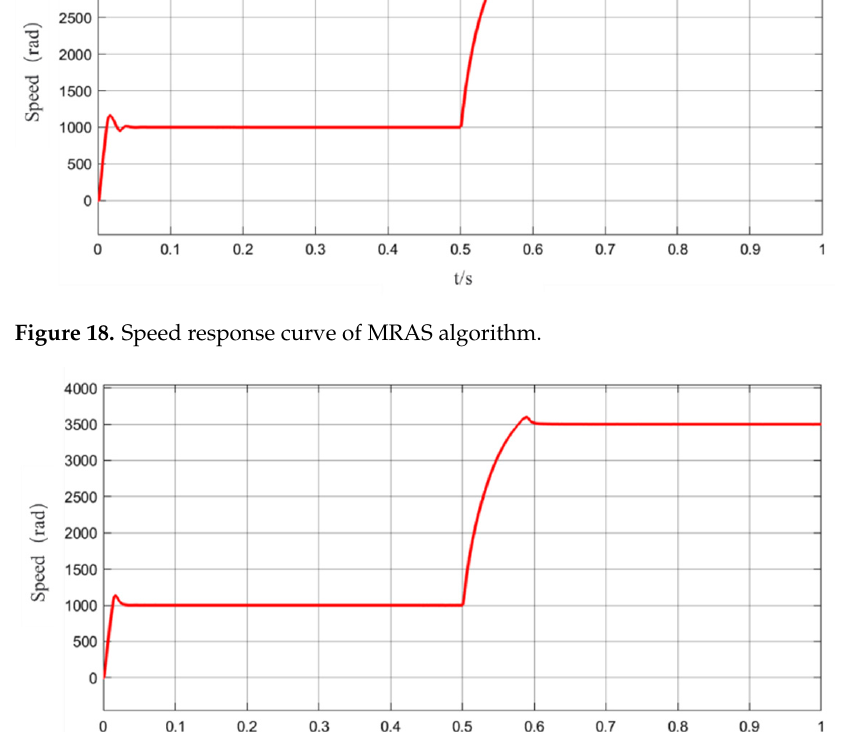
Figure 20. Torque response curve of MRAS algorithm. Figure 21. Torque response curve of STSM − MRAS algorithm. As can be seen in Figures 18 and 19, under the same working conditions, due to the change of PMSM inductance parameters, the STSM − MRAS algorithm still has a small overshoot after startup and speed change and can quickly reach the given speed value. It reaches the stable state faster than the traditional MRAS algorithm. As can be seen in Fig ‐ ures 20 and 21, when the inductance parameters of PMSM are perturbed, in the case of motor start and speed mutation, then compared with the traditional MRAS algorithm, the STSM − MRAS algorithm has a smaller overshoot and is relatively fast in reaching the sta ‐ ble state. In conclusion, the STSM − MRAS algorithm has better robustness than the tradi ‐ tional MRAS algorithm. 6. Conclusions In this paper, the position and speed estimation method of the MRAS rotor based on stator current is analyzed theoretically. The reference model equation and adjustable model equation are derived according to the stator current equation. The correctness of the selected linear compensator matrix is strictly proved. Based on Popov’s super stability